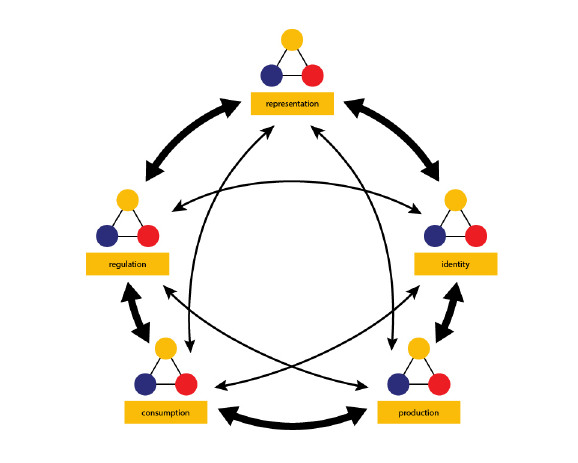
Fig. 9. Re-thinking the Circuit of Culture using Theory of